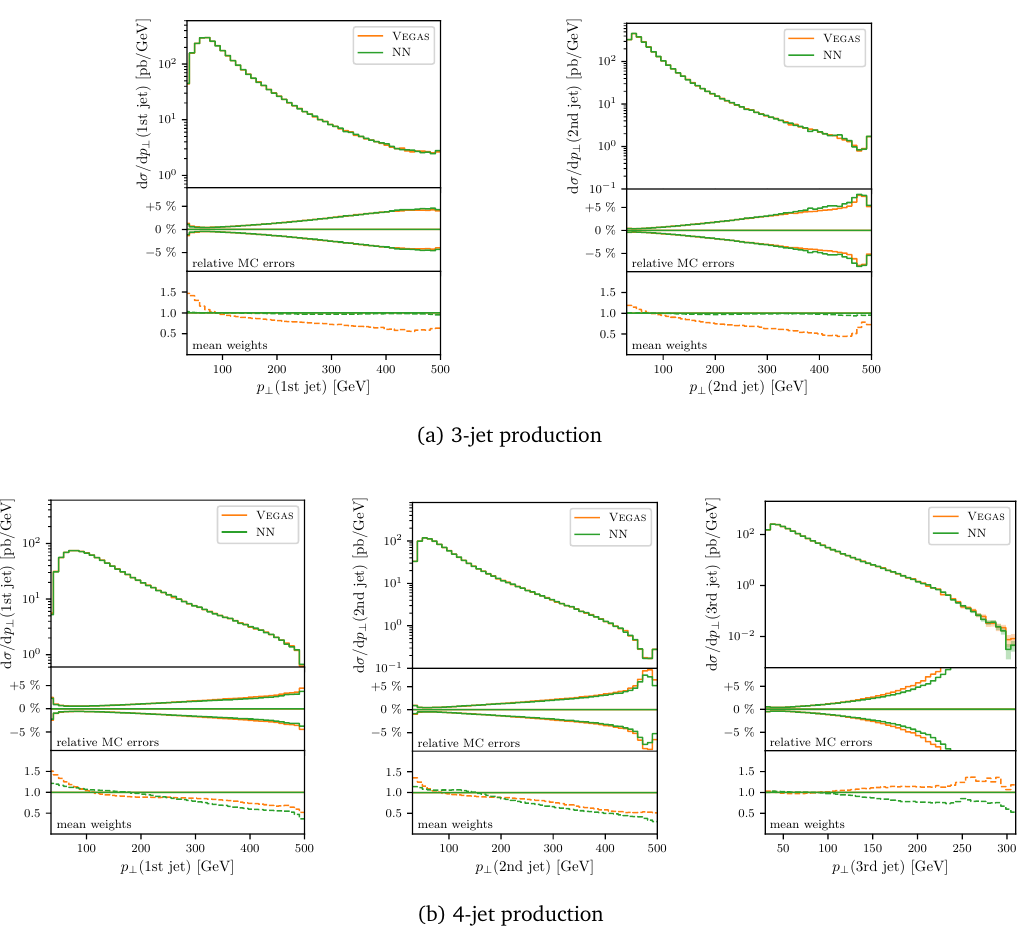
Figure 6: Distributions of the transverse momentum p ⊥ of the leading and second- leading jets in three-gluon production (a) and for the leading, second- and third- leading jets in four-gluon production (b) . For each observable, we compare the nom- inal distributions for a V EGAS -optimised and a NN-optimised phase space sampling (upper panes). In the middle panes of each plot, Monte Carlo errors for both samples are compared. The lower panes show the mean event weights per